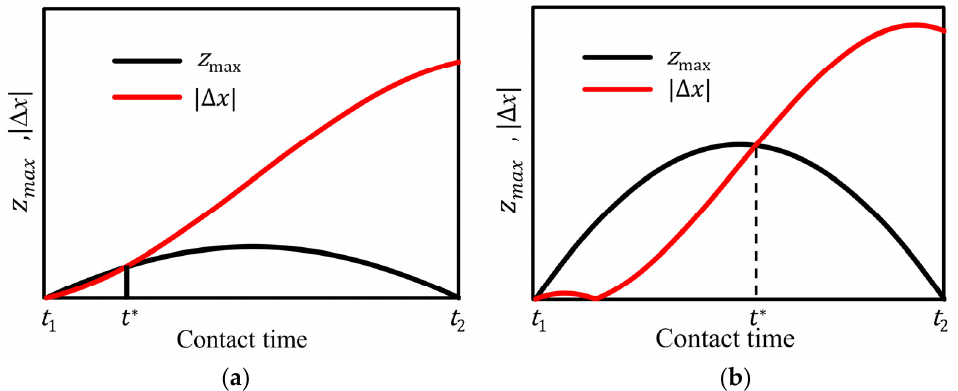
Figure 6. Curves of z max and | ∆ x | with respect to time corresponding to different v s . ( a ) v s < v t ( t 1 ), ( b ) v t ( t 1 ) < v s < v 0 .